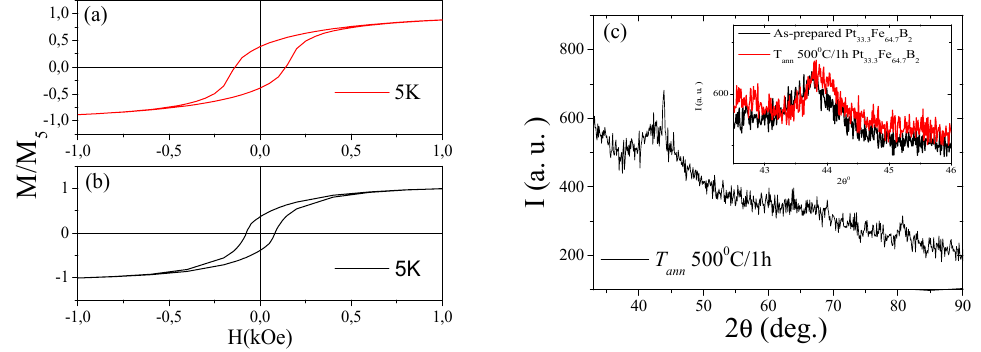
Figure 37. Hysteresis loops of as-prepared and annealed at 500 C for 1 h ( a ), and ( b ) Fe 33.3 Pt 64.7 B 2 microwires measured at 5 K and XRD of as-prepared and annealed Fe 33.3 Pt 64.7 B 2 microwires ( c ). The inset shows a zoom-in comparison between as-prepared and annealed Fe 33.3 Pt 64.7 B 2 samples. Reproduced from reference [48], Figure 4.